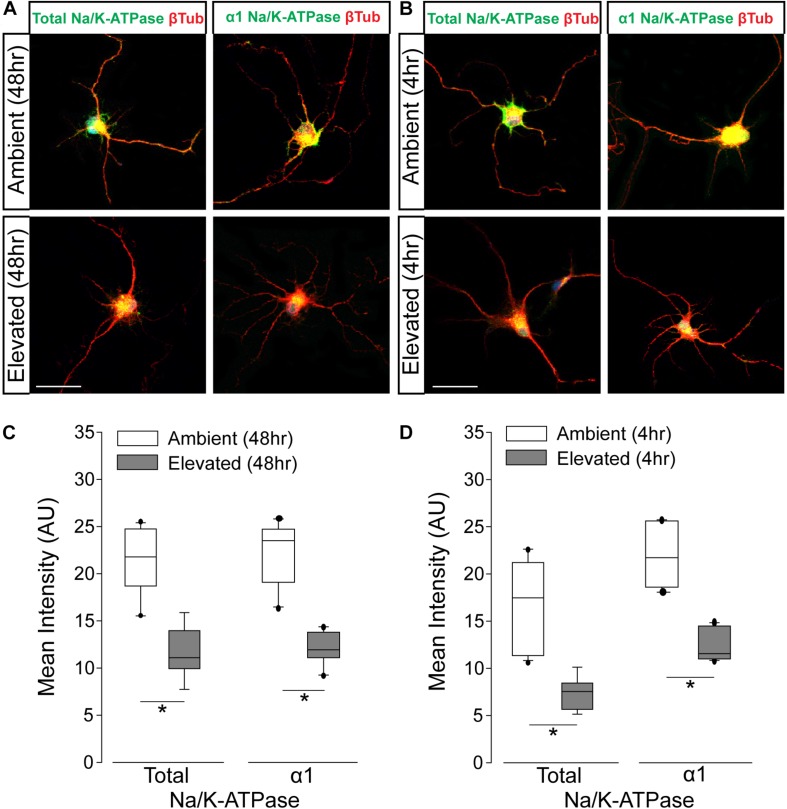
Elevated pressure decreases expression of total and α1 Na/K-ATPase in RGCs in vitro. (A) Representative fluorescent micrographs of total and α1 Na/K-ATPase (green) and β-Tubulin (red) immunolabeling in primary cultures of purified RGCs exposed to ambient or elevated pressure for 48 h. Scale bar = 40 μm. (B) Representative fluorescent micrographs of total and α1 Na/K-ATPase (green) and β-Tubulin (red) immunolabeling in primary cultures of purified RGCs exposed to ambient or elevated pressure for 4 h. Scale bar = 40 μm. (C) Mean intensity (arbitrary units; AU) of total (left) and α1 (right) Na/K-ATPase staining in RGC cultures following a 48-h exposure to ambient or elevated hydrostatic pressure. ∗p < 0.05. Total: n(AMB48) = 10 cells, n(ELEV48) = 9; α1: n(AMB48) = 13, n(ELEV48) = 11. (D) Mean intensity (arbitrary units; AU) of total (left) and α1 (right) Na/K-ATPase staining in RGC cultures following a 4 h exposure to ambient or elevated hydrostatic pressure. ∗p < 0.05. Total: n(AMB4) = 14 cells, n(ELEV4) = 9; α1: n(AMB4) = 10, and n(ELEV4) = 10.